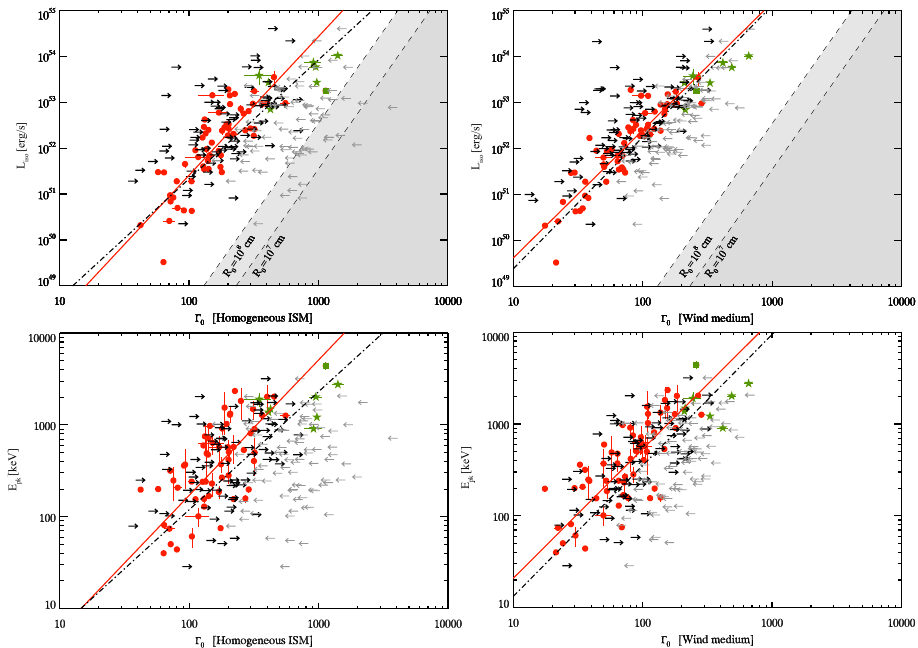
Figure 8. The Γ 0 - L pk ( top ) and Γ 0 - E pk ( bottom ) correlations taken from Ghirlanda et al. [195]. The left and right panels display the two cases in which homogeneous and wind profile are assumed for the CBM, respectively. The red circles (green stars) correspond to the LGRBs with measured t pk in optical (GeV) band, while the green square corresponds to short GRB090510. The rightward (leftward) arrows show the deduced values of lower (upper) limits on Γ 0 for GRBs without detection of t pk . Credit: Ghirlanda et al., A&A, 609, A112, 2018, reproduced with permission